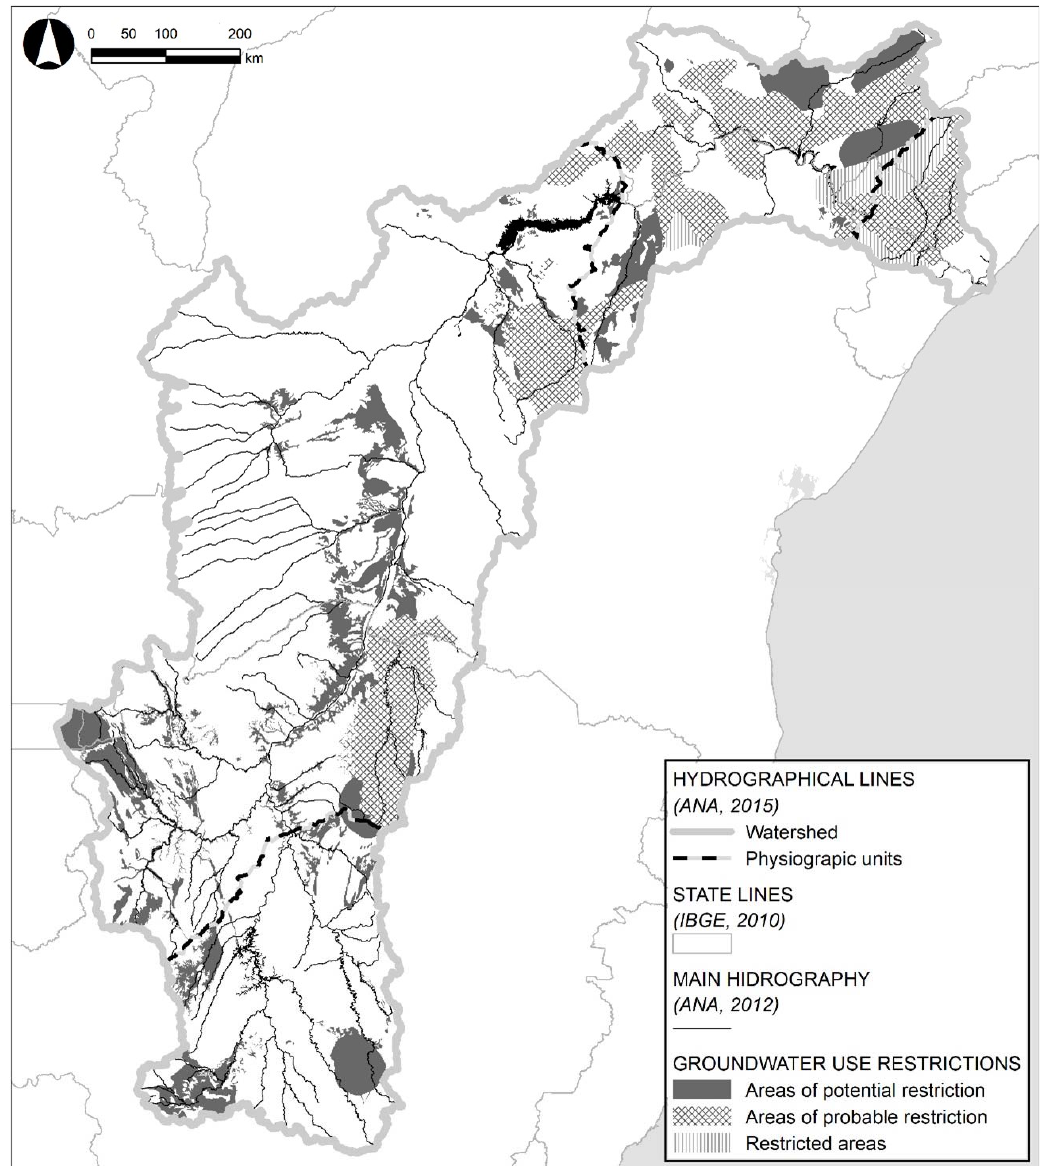
Figure 4. Areas subject to groundwater use restrictions